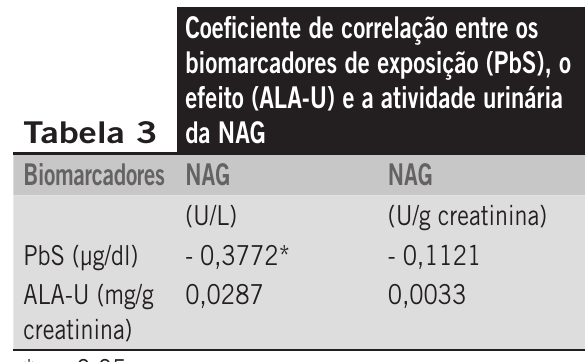
a Tabela 2. Este intervalo está em conformidade com os propostos por Horak et al. (10) , 0,4-5,6 U/g de